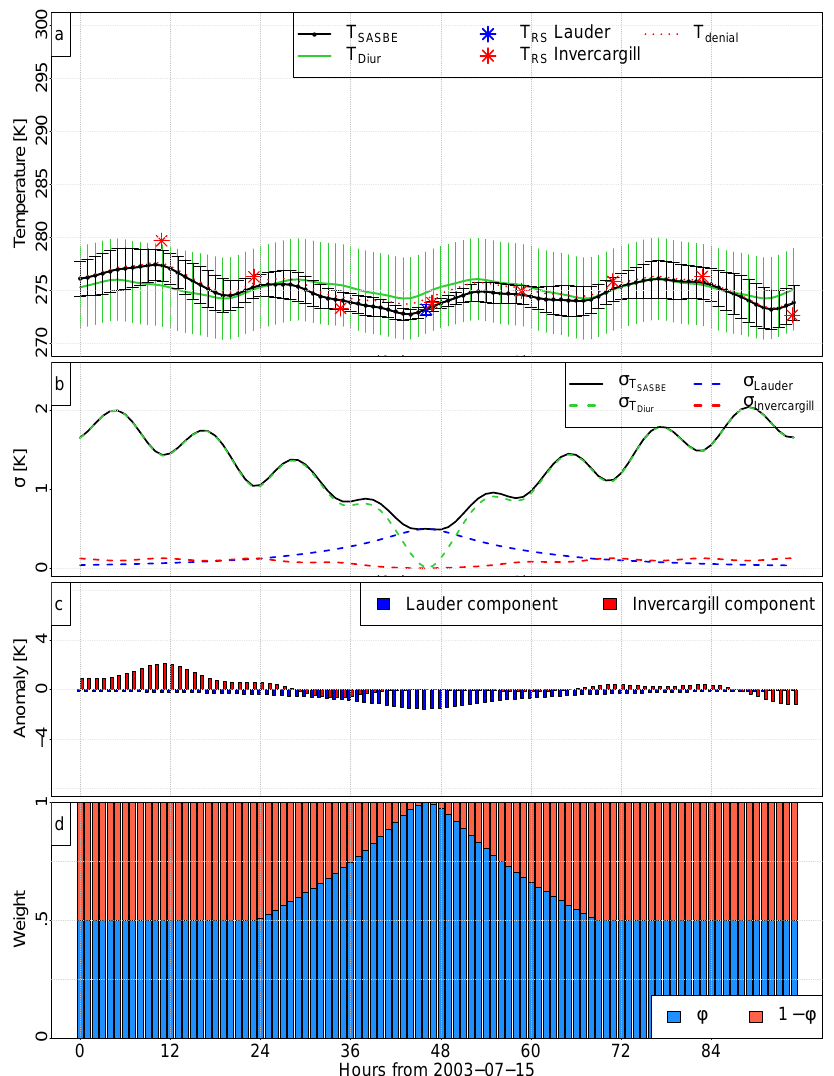
Figure 7. As in Fig. 4, but for 4 days in July 2003 at 925hPa.